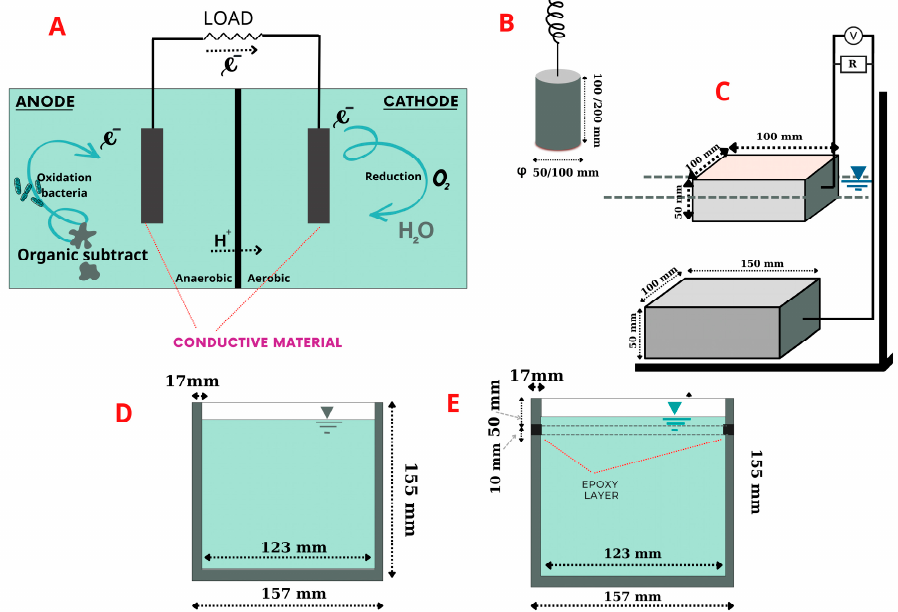
Figure 1. Experimental apparatus and materials: ( A ) MFC model; ( B ) single-chamber MFC with air cathode; ( C ) plate specimens; ( D ) cup specimens; ( E ) cup specimens with epoxy-layer insulator.